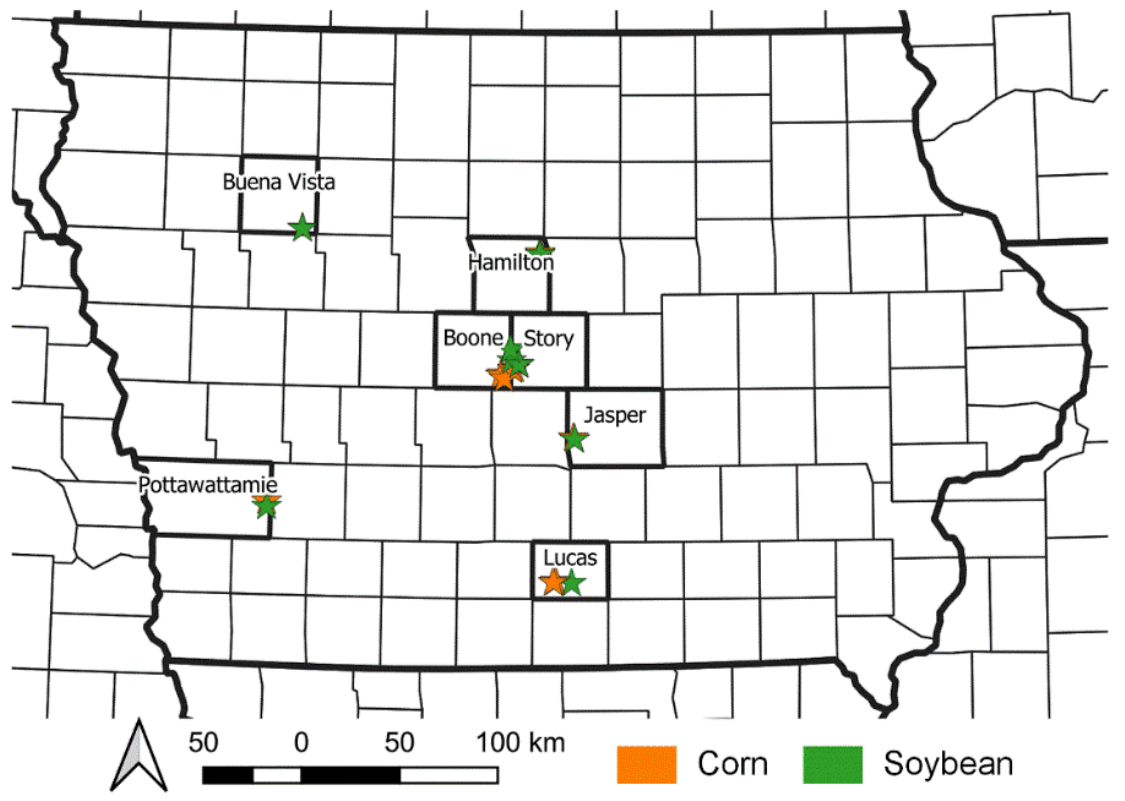
Figure 1. Distribution of corn and soybean fields in Iowa, USA. Average per-field yield values as well as planting and harvest dates are shown in Figure 2. The average yield for corn was 12.1 t/ha and varied from 9.6 t/ha to 13.6 t/ha and for soybean was 3.9 t/ha and varied from 2.4 t/ha to 4.5 t/ha. On average, corn and soybean were planted on 4 May (day of year (DOY) 124) and 23 May (DOY 143).